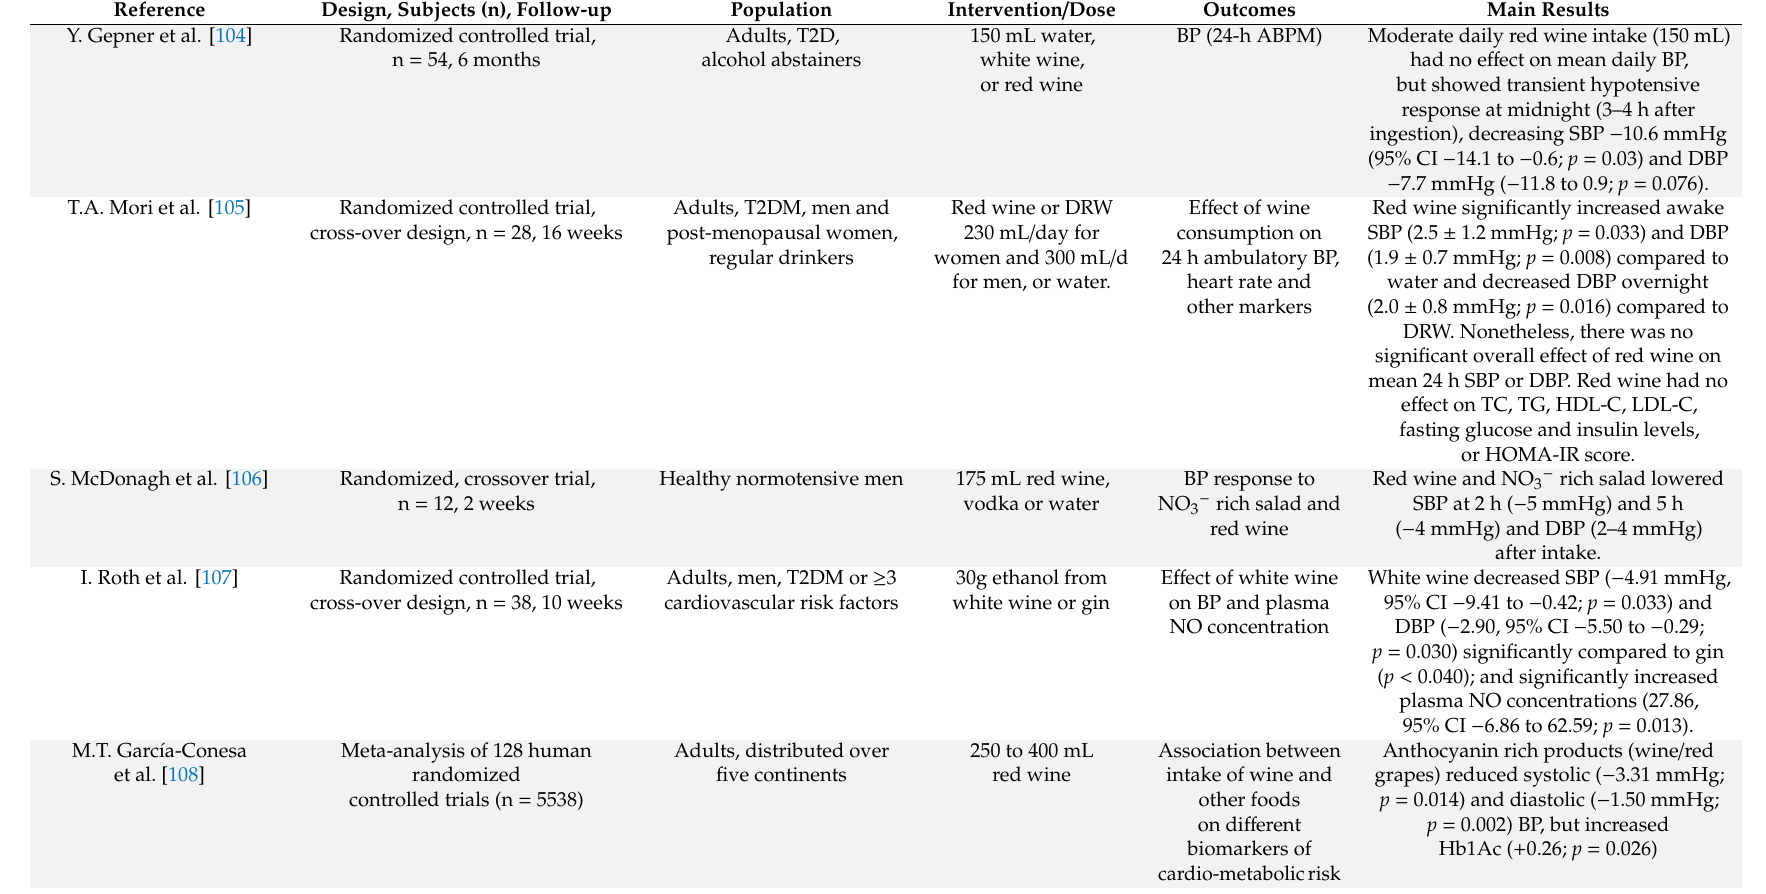
Table 1. Summary of study characteristics, outcomes and main results of studies included in the